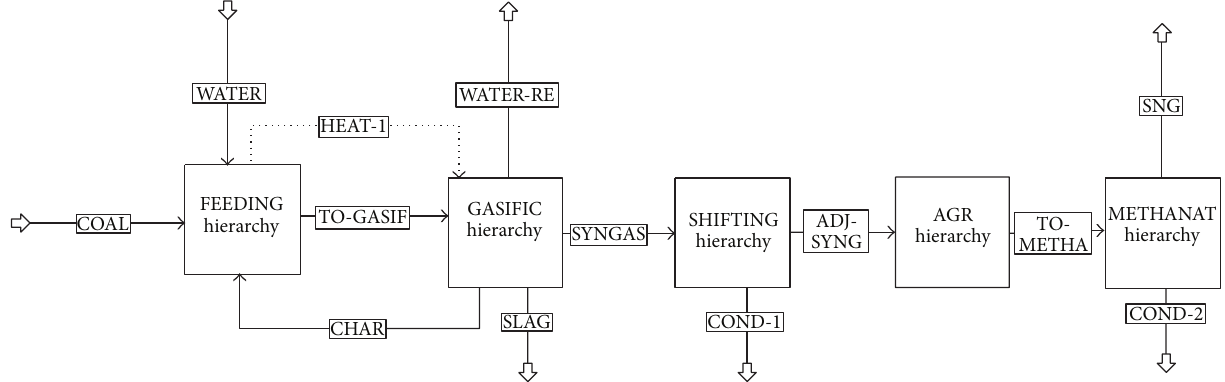
Figure 3: Aspen Plus process flow sheet for SNG production via coal gasification using slurry feeding technology (ConocoPhillips 66).